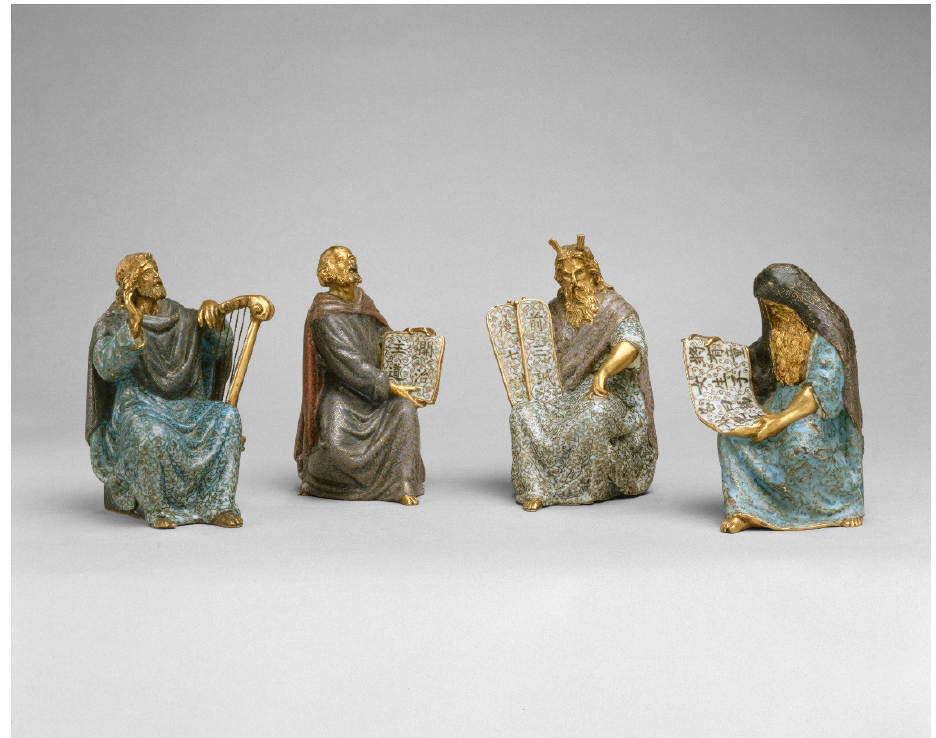
Figure 1. Figurines of prophets, 18th century, China. Metropolitan Museum of Art, New York. Photo: Metropolitan Museum of Art, Public Domain.